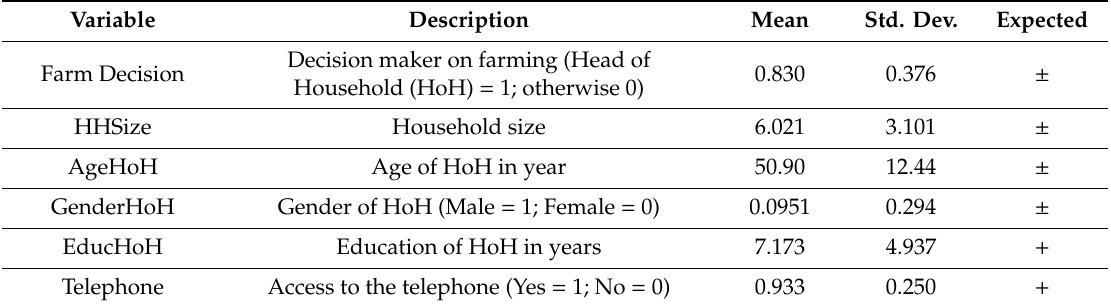
Table 2. Explanatory